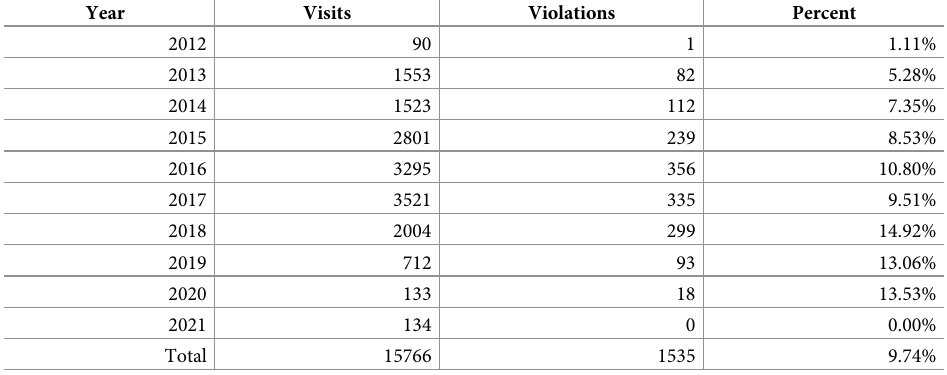
Table 1. Counts of compliance check visits, sales to minor violations, and percent of visits with a sales violation by year and overall in